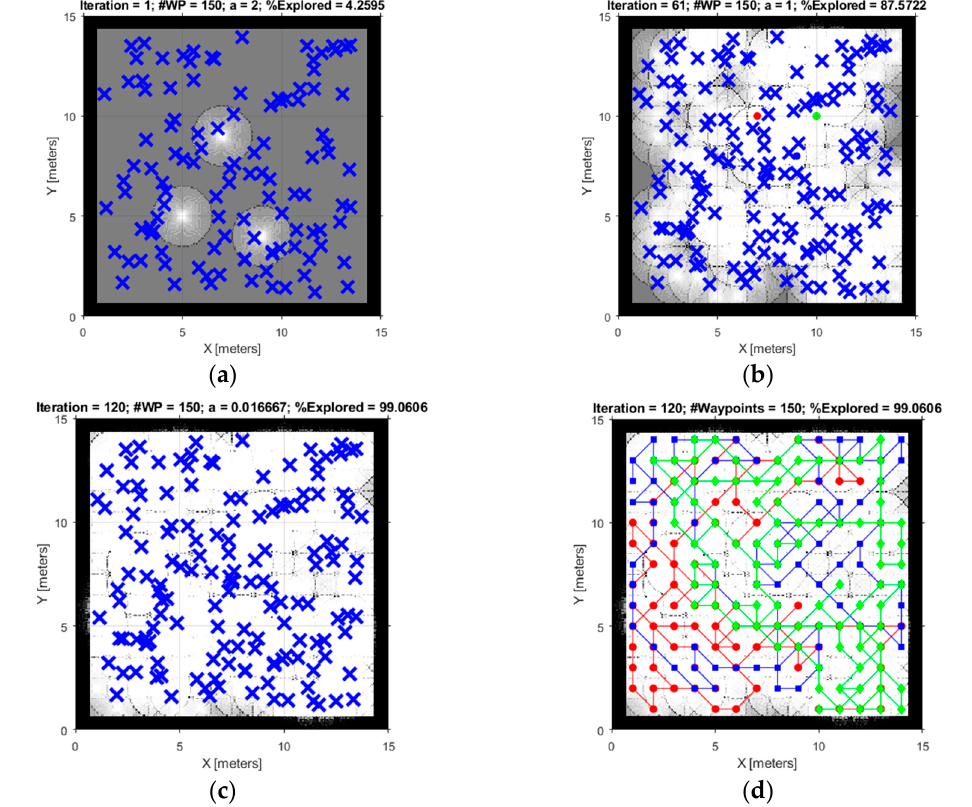
Figure 6. The simulation of MOGWO exploration algorithm in ( a ) iteration 1 with a = 2; ( b ) iteration 61 with a = 1; ( c ) the last iteration, 120, with a = 0.016; and ( d ) the trajectories of three robots.